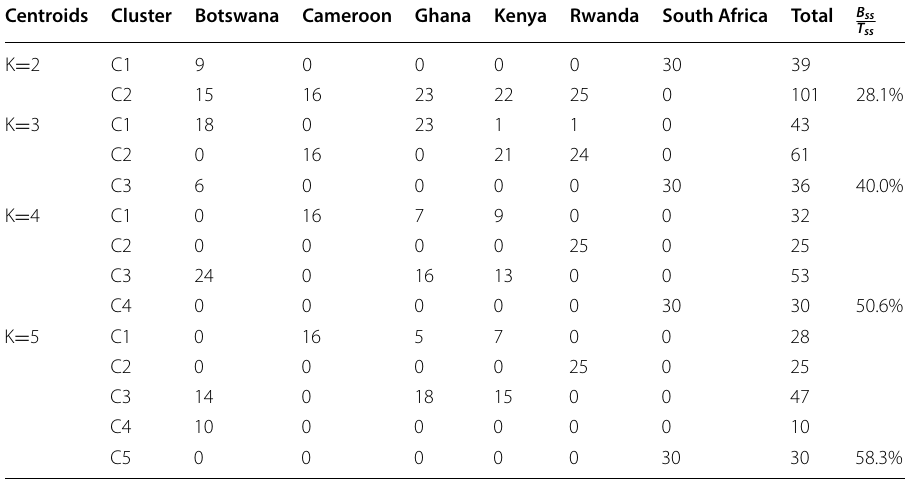
Africa versus the rest, which is similar to the pattern observed with PCA in Figure 4. While South Africa still dominates under K = 3, Botswana and Ghana dominate one cluster while Cameroon, Kenya and Rwanda dominate the other cluster. Particularly important is the last column in Table 3, exhibiting the ratio B ss (between-cluster sum of squares) over T ss (the total sum of squares), giving what is basically the within- cluster sum of squares. The K-Means algorithm uses the minimum sum of squares to identify clusters. The algorithm iteratively updates cluster centres, allocating observa- tions as it goes and stops only when the maximum number of iterations is reached or the change of within-cluster sum of squares in two successive iterations is less than the set threshold. Thus, the values in the last column of Table 3 measures the total variance in the dataset that is due to that level of clustering. That is, by assigning the samples to the specified clusters rather than the total number of samples, we are able to show the reduction in the sum of squares each cluster achieved.